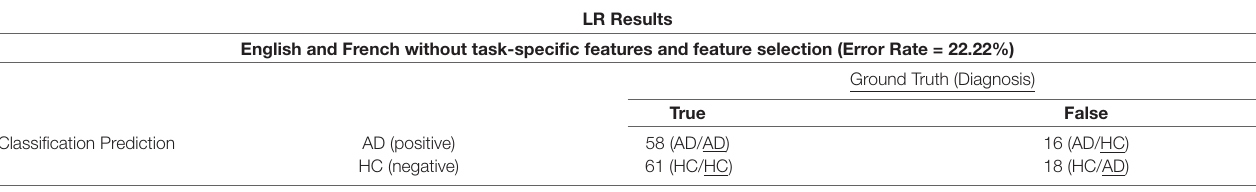
TABLE 4 | Confusion matrices for the final robust classifier without task-specific features using multilingual significance feature selection.